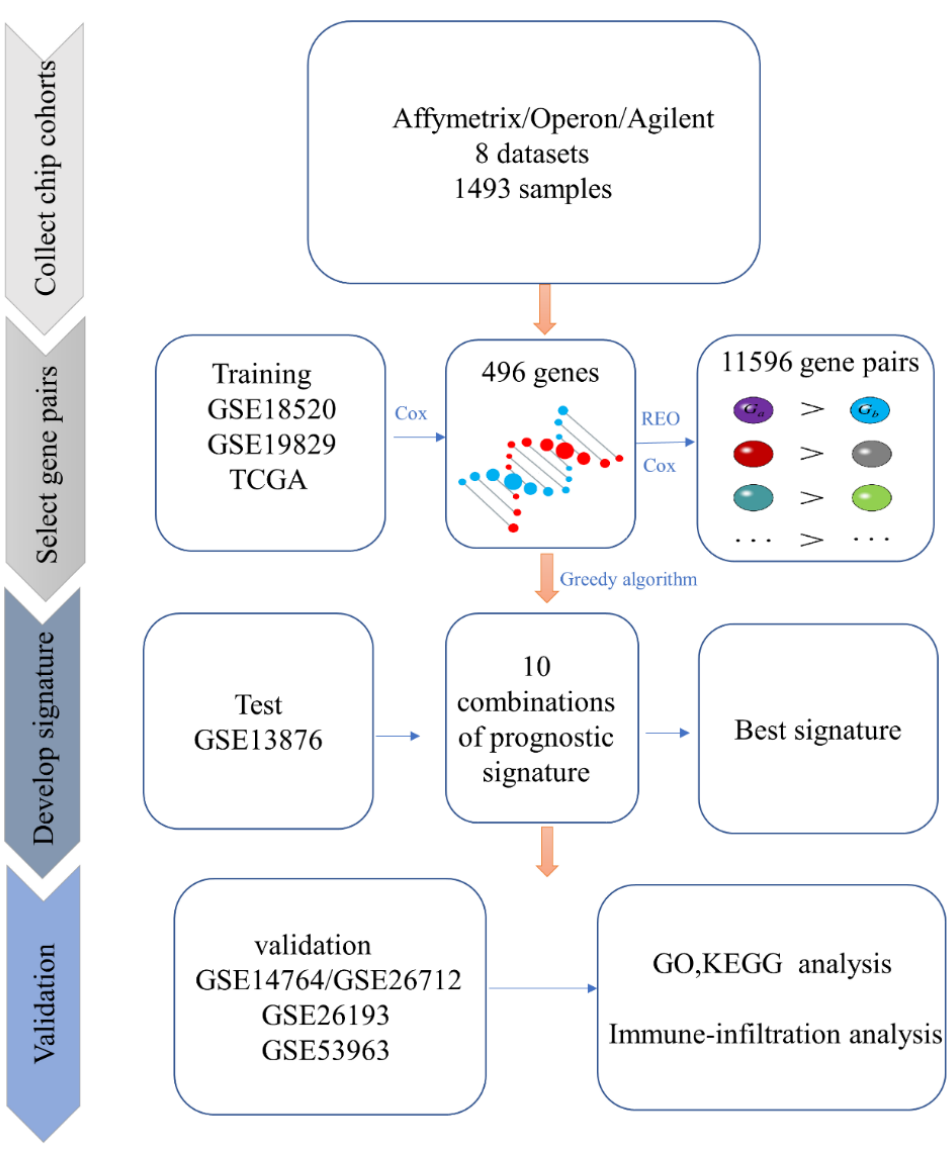
Figure 1. Flow chart of the study. Table 1. Clinical characteristics of serous ovarian cancer samples used in this study.